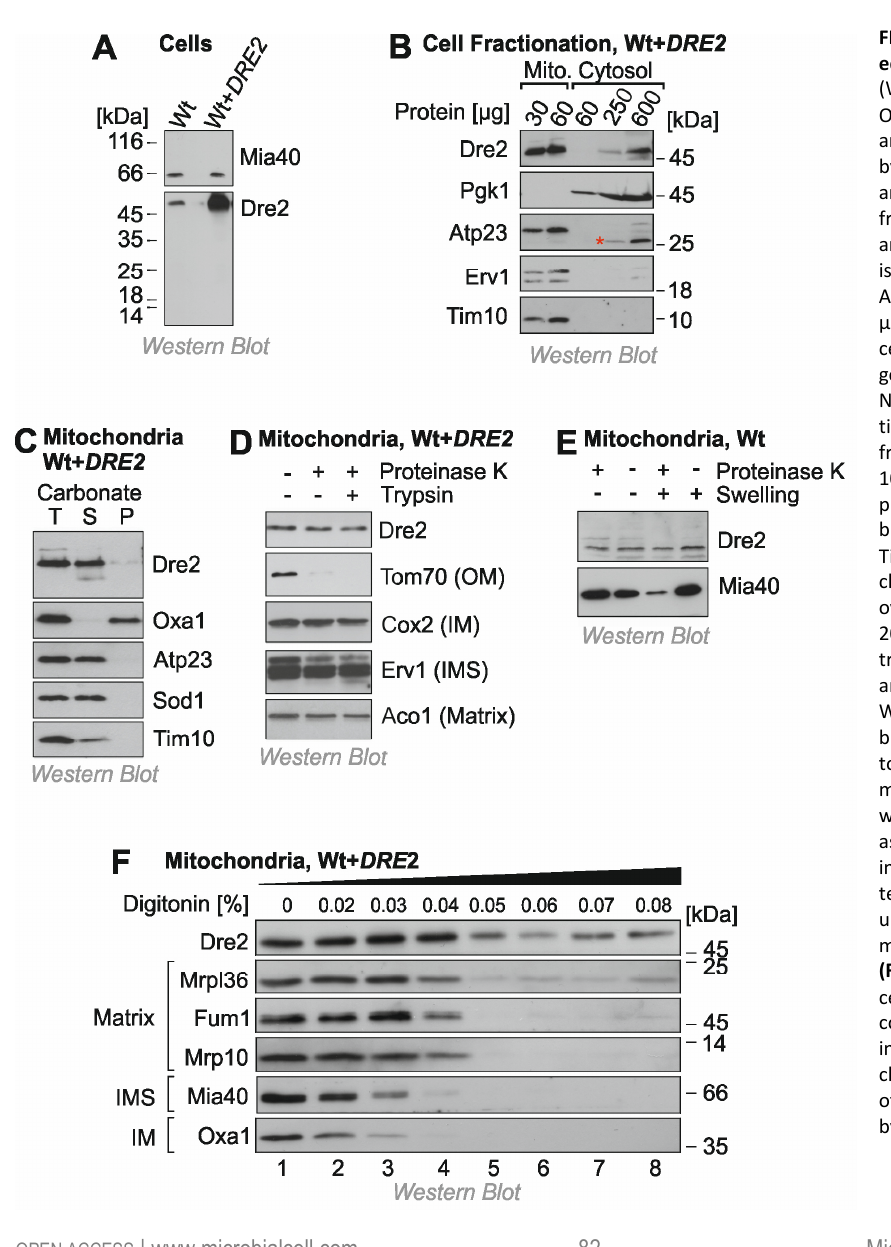
(F) Mitochondria of Dre2-overexpressing cells were incubated with increasing concentrations of the detergent